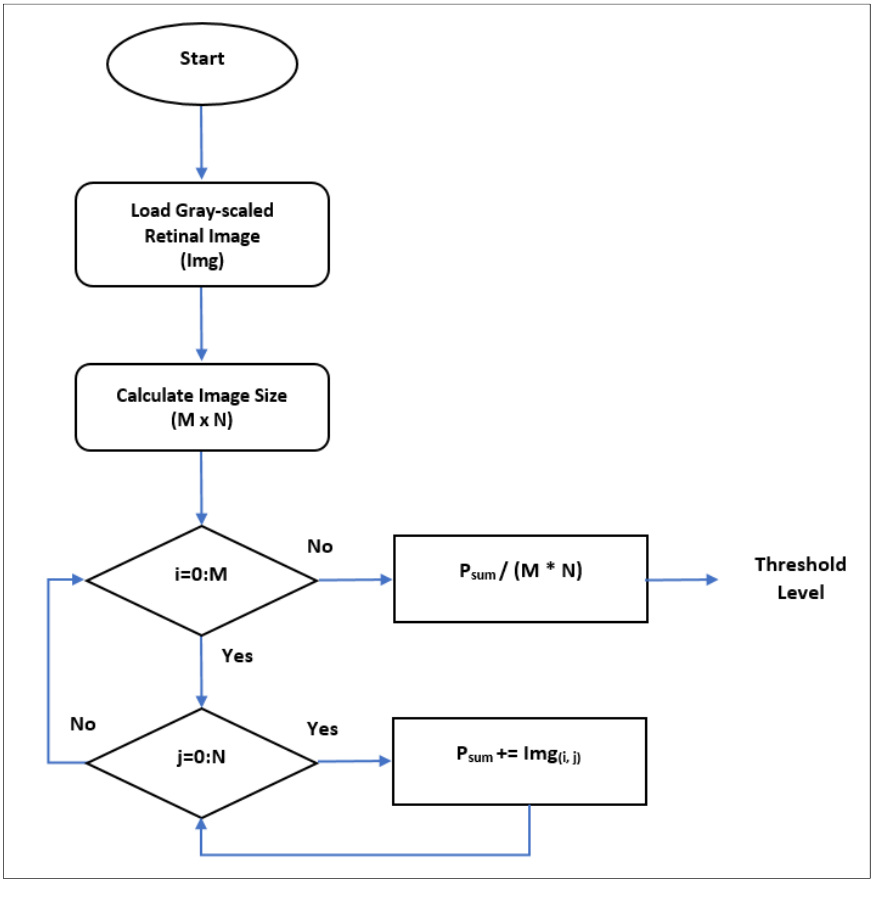
Figure 5. Block diagram for the calculation of the average brightness level.